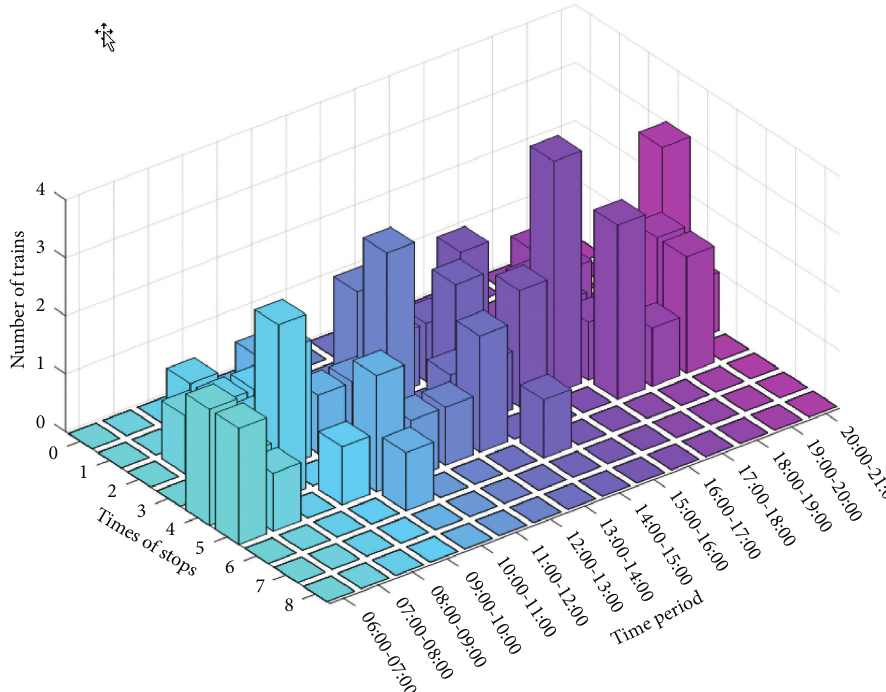
Figure 15: Number of trains with different number of stops in each period.